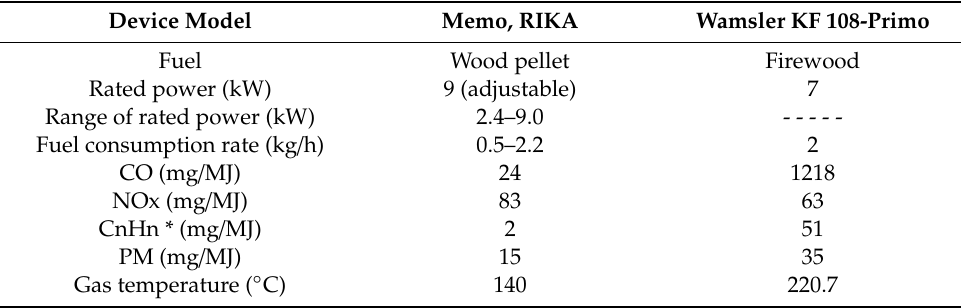
Table 1. Characteristics of the combustion devices.